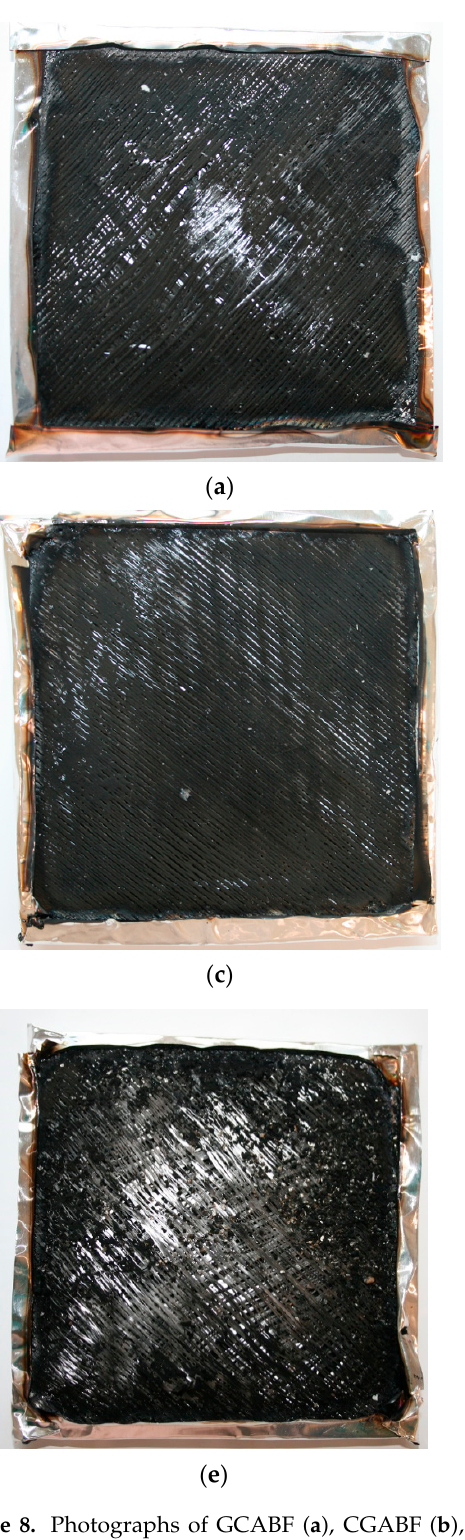
Figure 8. Photographs of GCABF ( a ), CGABF ( b ), CAGBF ( c ), MAGCBF ( d ), VGACBF ( e ), MGACBSF ( f ) after cone calorimetry tests.